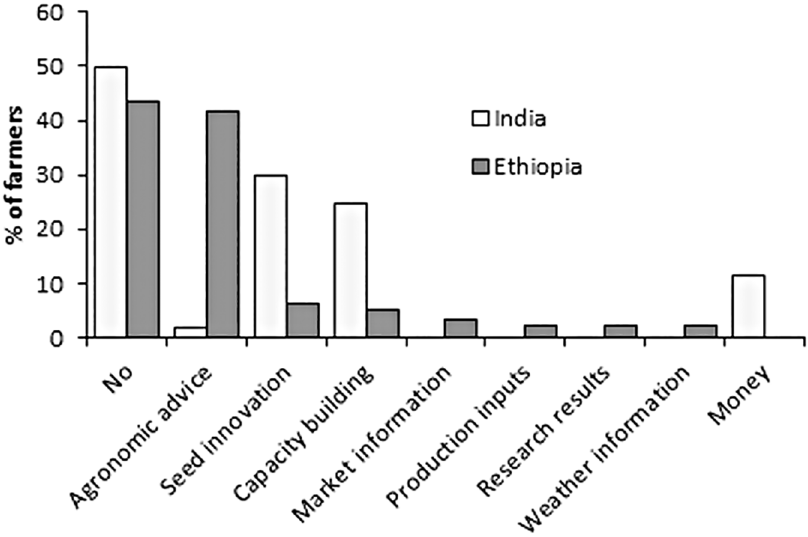
Fig 7. Types of rewards farmerswould like to receivefor sharing agronomic